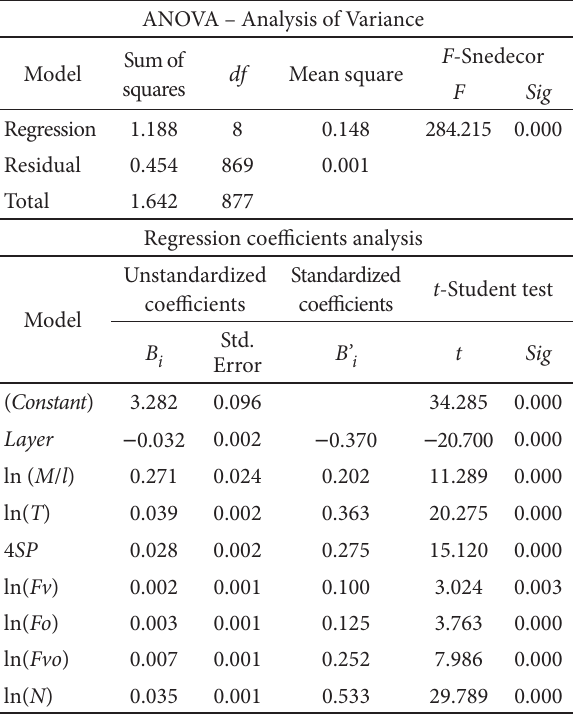
table 6. NDG data regression analysis